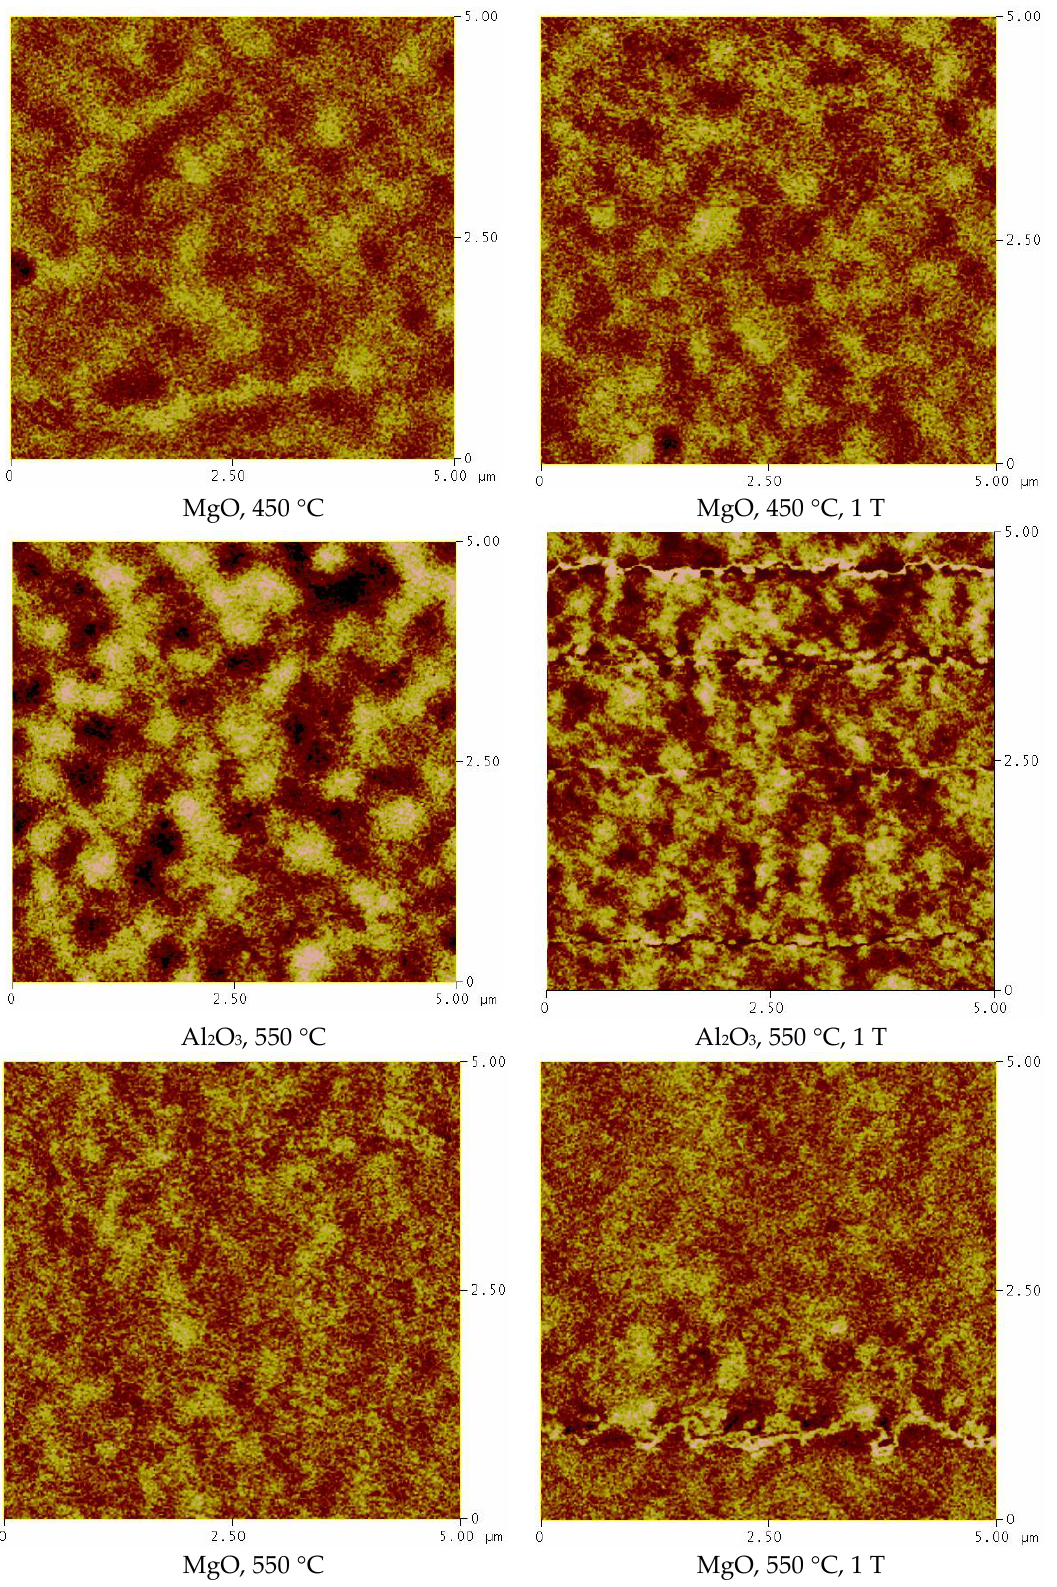
Figure 5. MFM images for the Fe 3 O 4 films grown in different conditions. The dimensions of the squares are 5 μm.